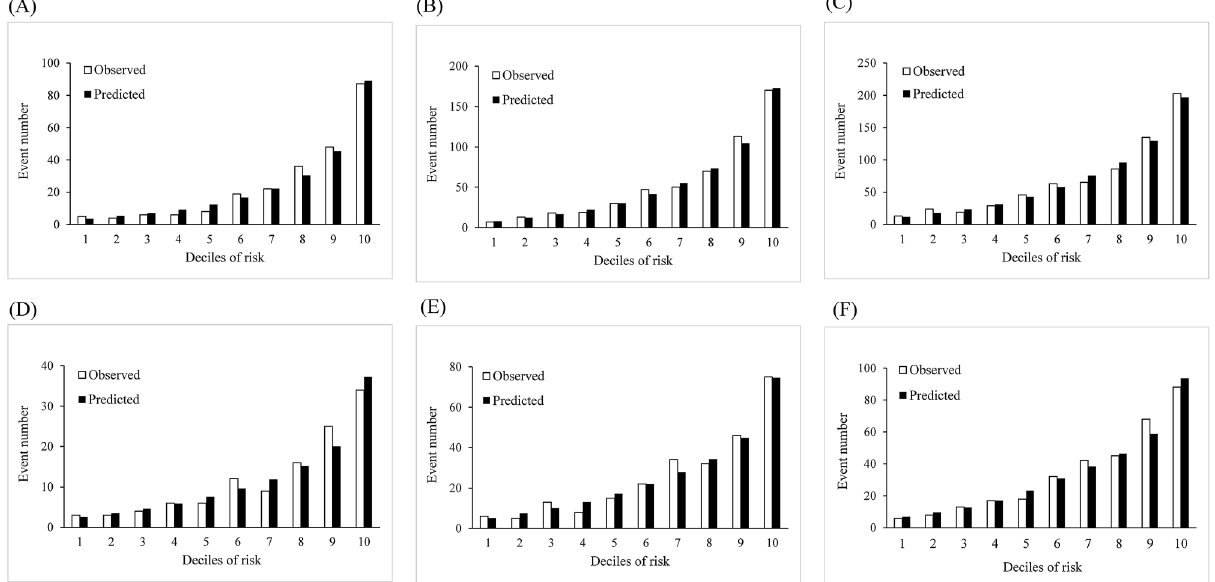
Figure 3. Predicted versus observed CKD cases according to deciles of 1-year ( A ), 3-year ( B ), and 5-year ( C ) CKD risk in derivation set and 1-year ( D ), 3-year ( E ), and 5-year ( F ) CKD risk in validation